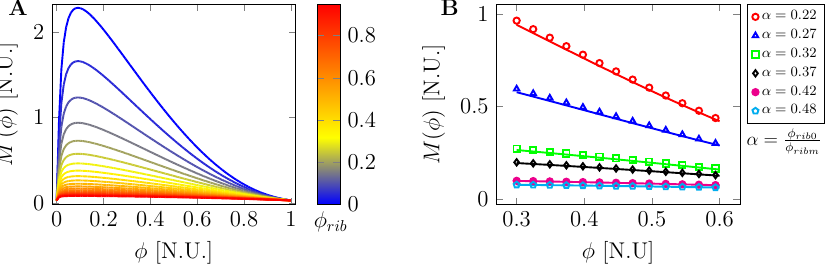
Figure 3. Mobility dependence on volume fraction for various crowder concentrations: ( A ) mobil- ity against volume fraction at low and high ribosome crowder concentration, φ rib . At very high crowder concentration, the mobility is very low and almost constant for changes in volume fraction. The mobility sharply increases for a small change in volume fraction, particularly at low crowder concentration; and ( B ) changes in mobility at low crowder concentration φ rib = 0.2 (solid lines) and high concentration φ rib = 0.8 (marks) for various control parameters α in the experimental range from 0.22 to